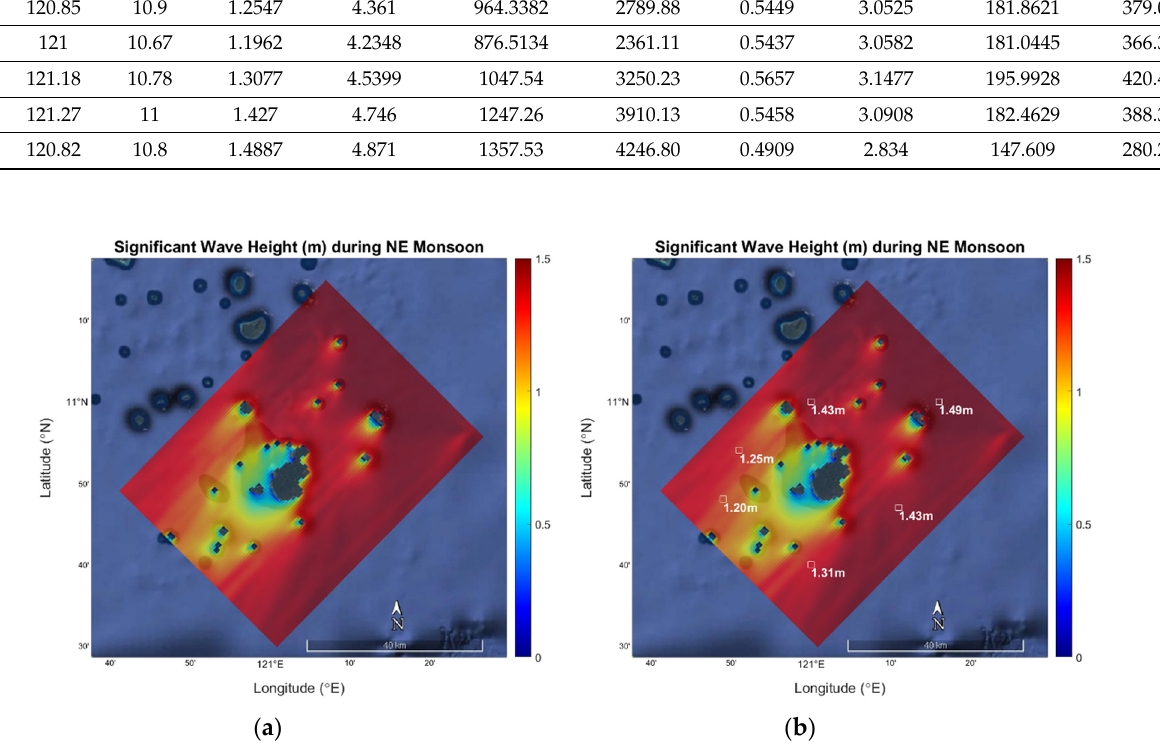
Figure 15. ( a ) H s (m) model during northeast monsoon season and ( b ) H s model indicating the average H s at stations A–F.